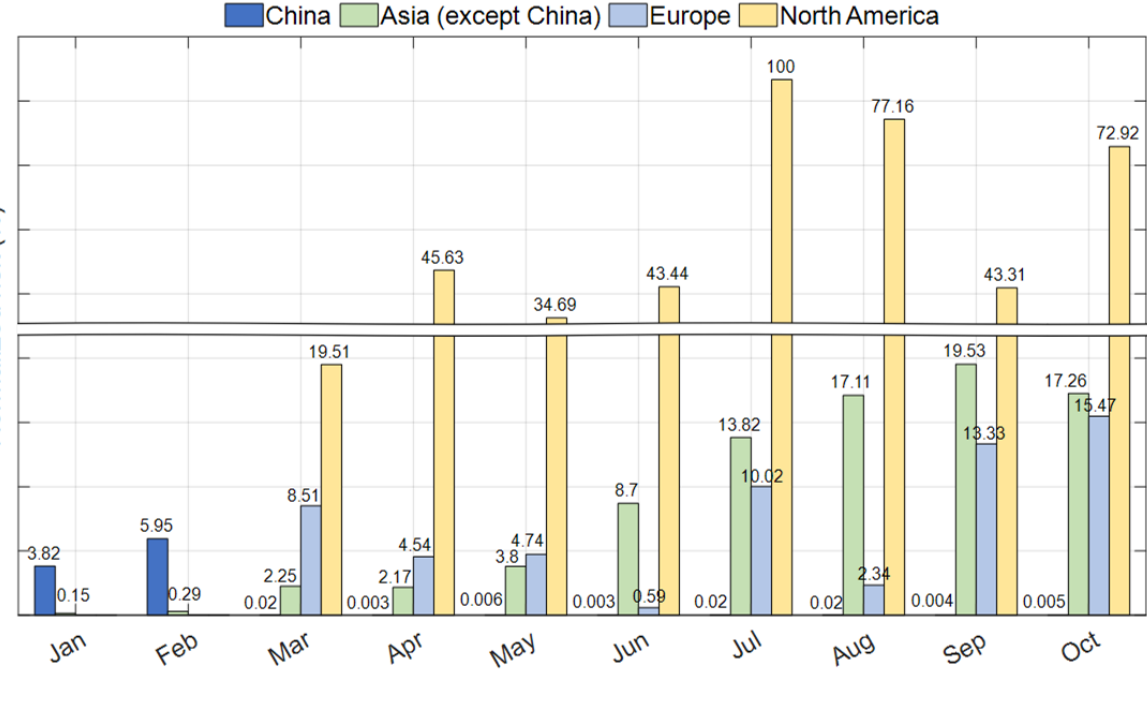
Lee et alJMIR PUBLIC HEALTH AND